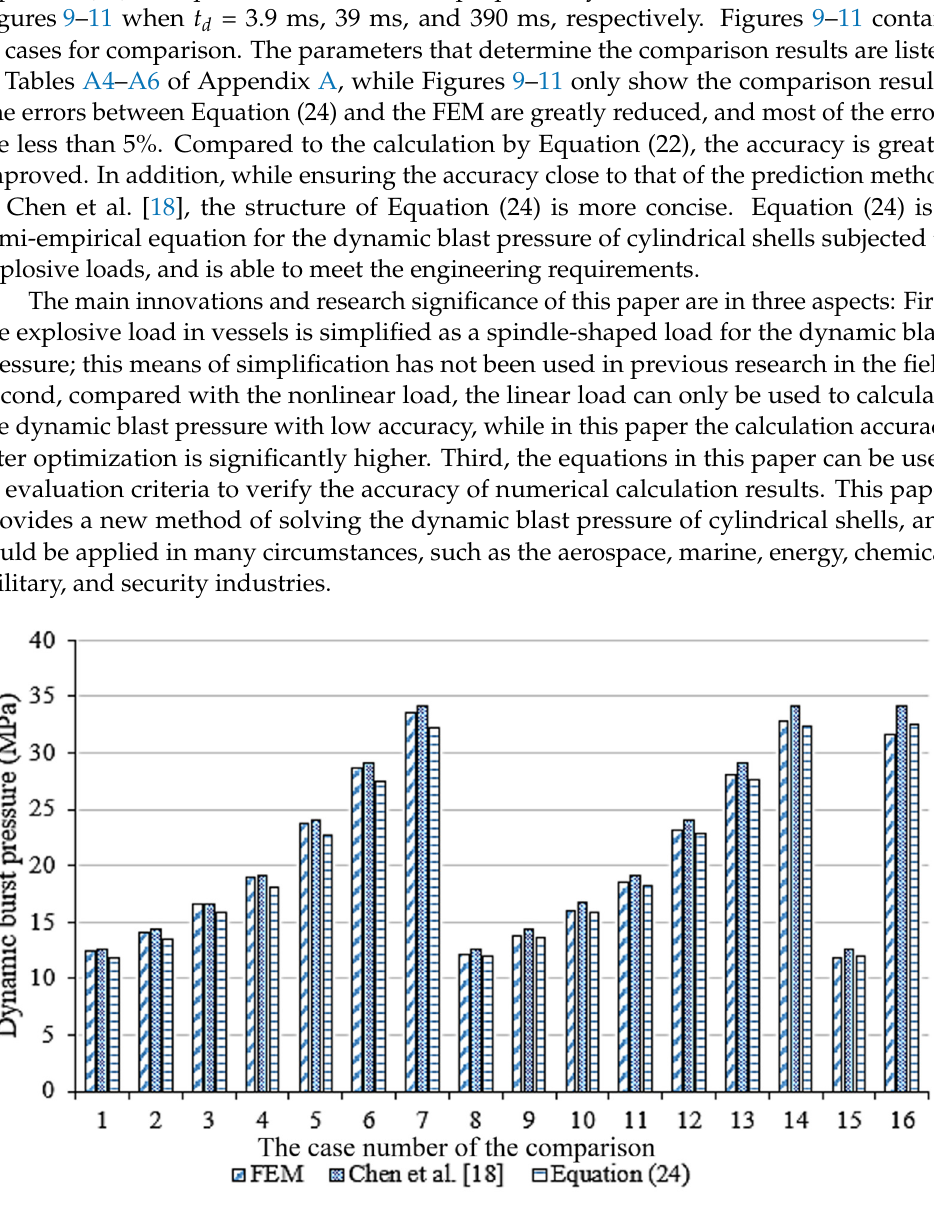
Figure 10. Comparisons between the FEM results and Equation (24), when t d = 39 ms.